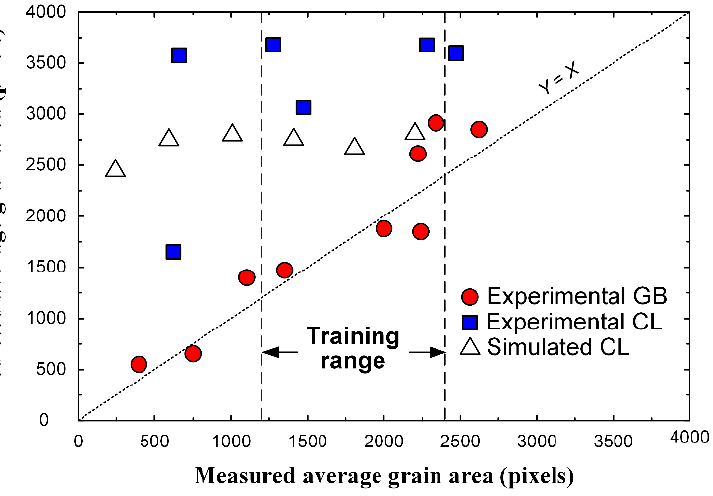
Figure 9. Comparison between the measured and predicted average grain area for datasets of experimental and simulated images.